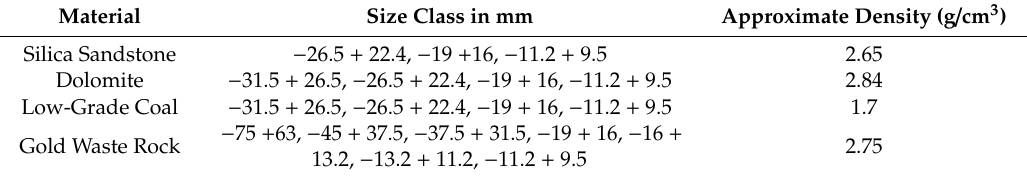
Figure 3. Sample preparation steps. Table 1. Size classes used of the di ff erent material used for drop weight